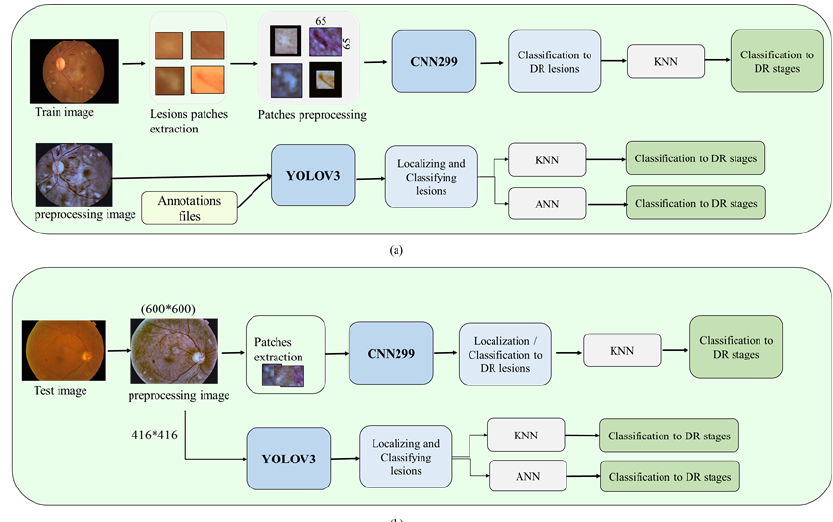
Figure 11. The proposed Lesion Localization method to detect DR stages and locate lesions for ( a ) train and ( b ) test images.